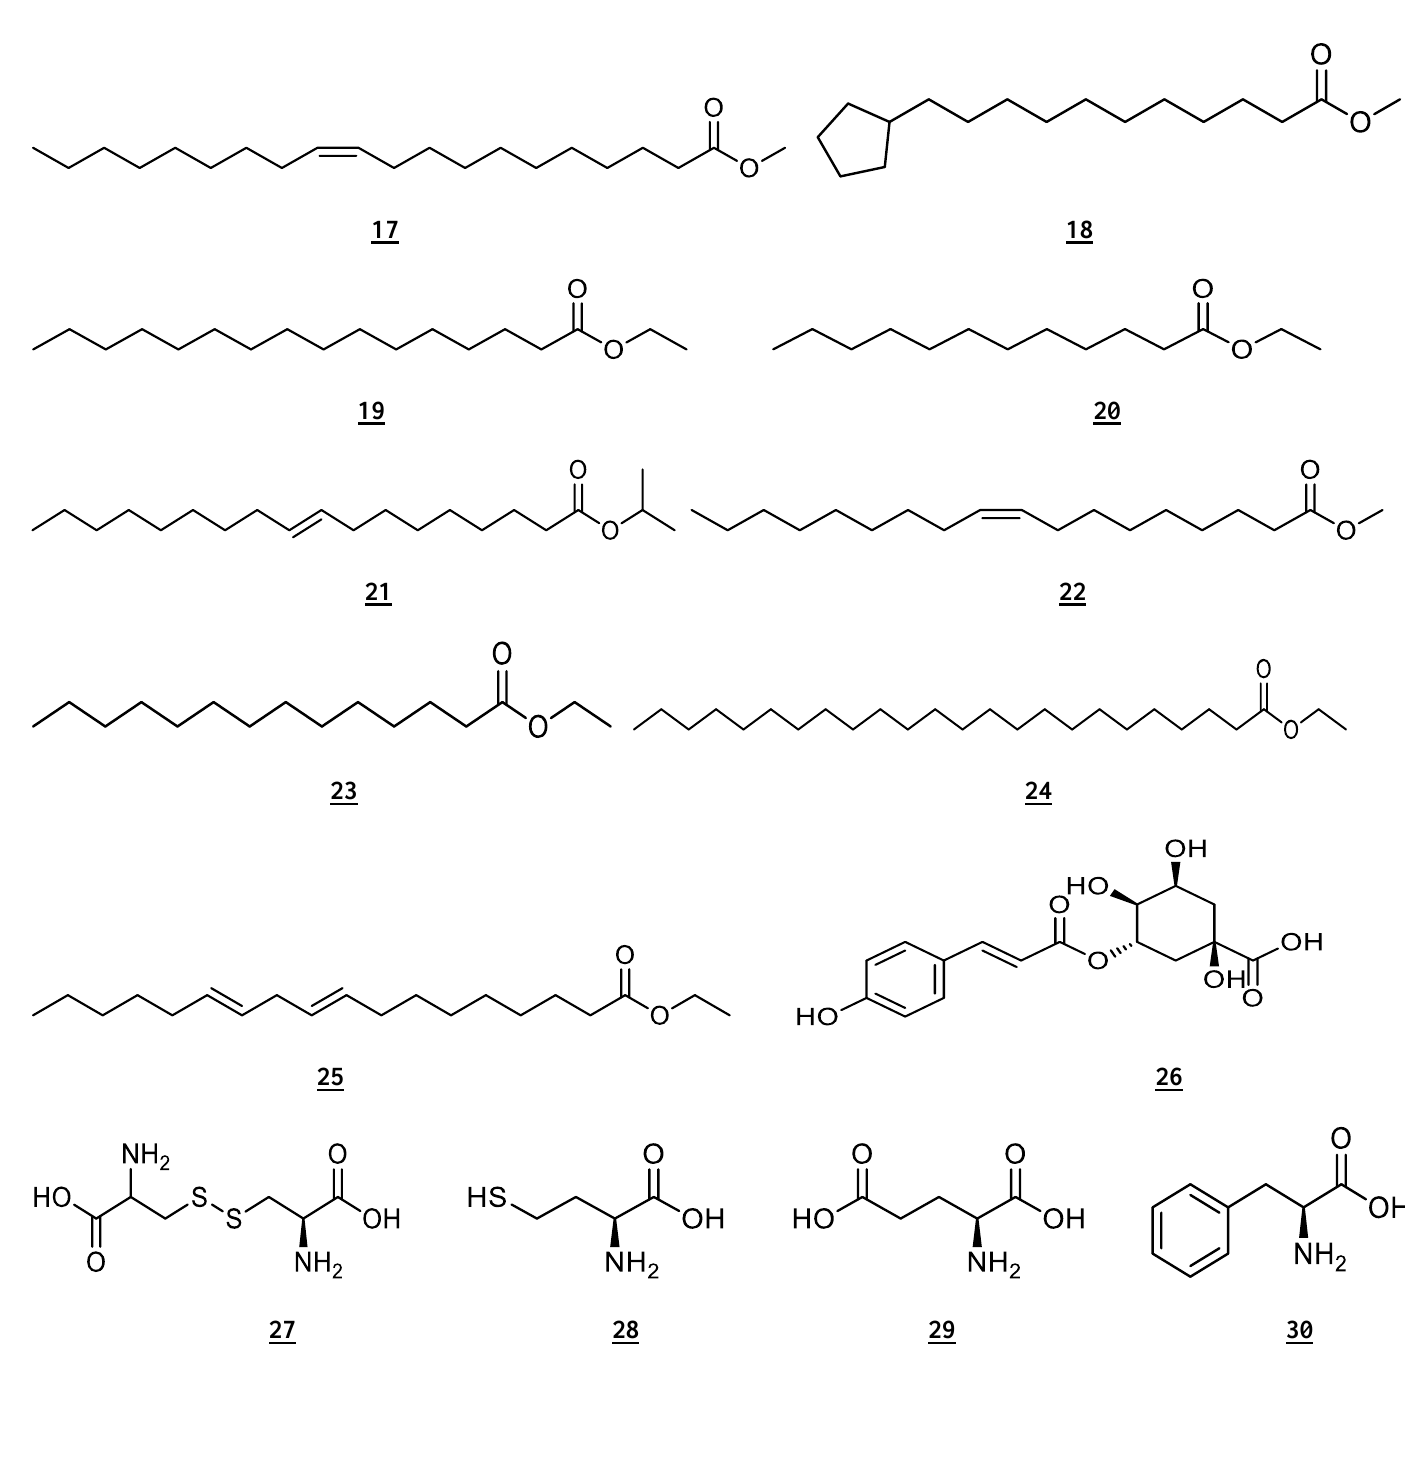
Fig. 2. Chemical structures of phenolic acids, amino acids, fatty acids and fatty acid esters isolated from C.